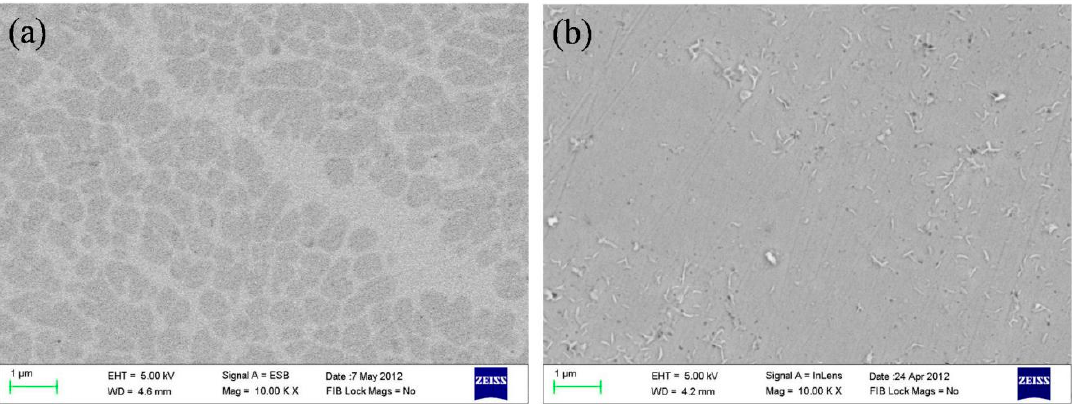
Figure 6. Longitudinal section morphology of fibers ( a ) x = 3 ( b ) x = 0.